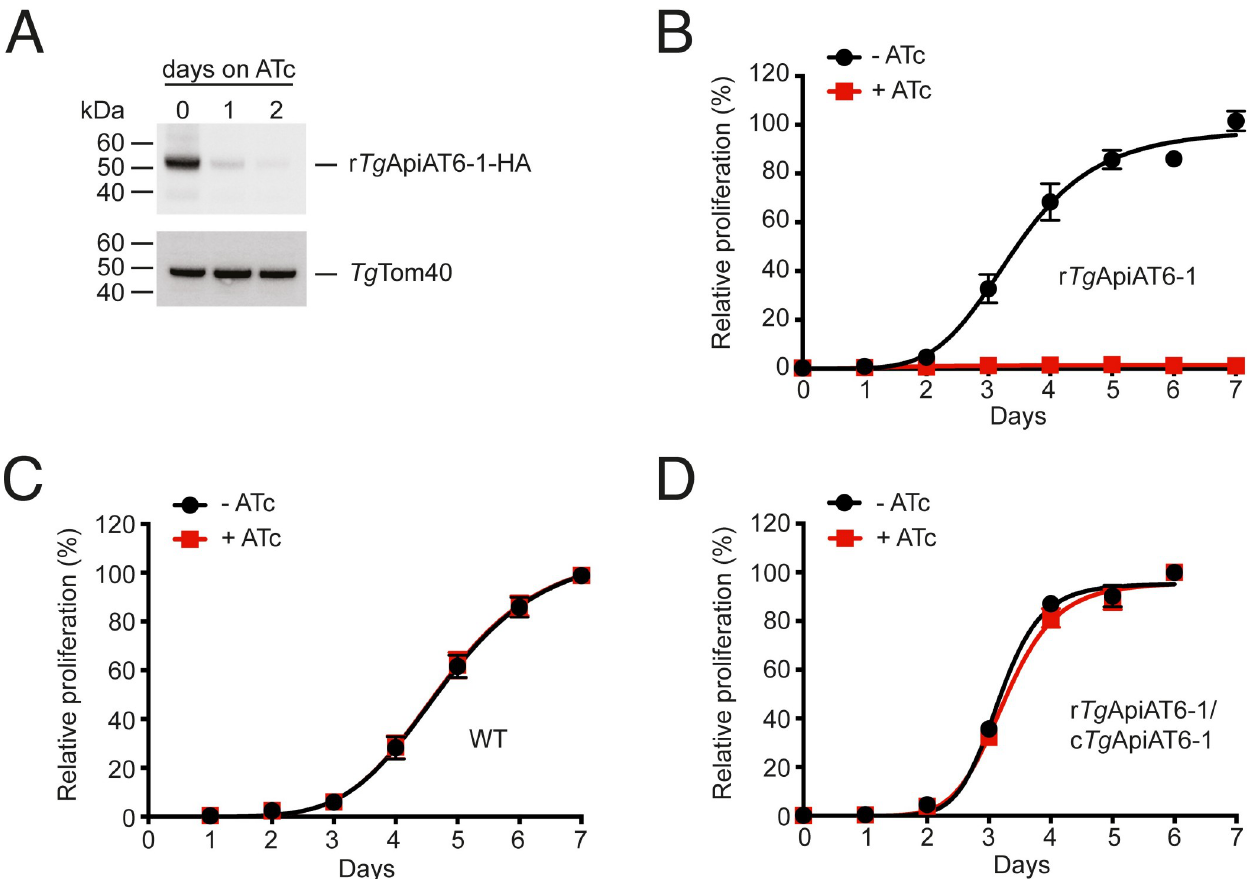
Fig 1. Tg ApiAT6-1 is important for parasite proliferation. A . Western blot analysis of proteins extracted from r Tg ApiAT6-1-HA parasites cultured in the presence of ATc for 0–2 days, and detected with antibodies against HA or Tg Tom40 (as a loading control). B-D . Fluorescence growth assays measuring the proliferation of r Tg ApiAT6-1 parasites (B), WT parasites (C), or r Tg ApiAT6-1 parasites complemented with a constitutively-expressed copy of Tg ApiAT6-1 (r Tg ApiAT6-1/c Tg ApiAT6-1; D). Parasites were cultured for 6 or 7 days in the absence (black) or presence (red) of ATc. Parasite proliferation is expressed as a percentage of parasite proliferation in the -ATc condition on the final day of the experiment for each strain. Data are averaged from 3 technical replicates ( ± S.D.) and are representative of three independent experiments.